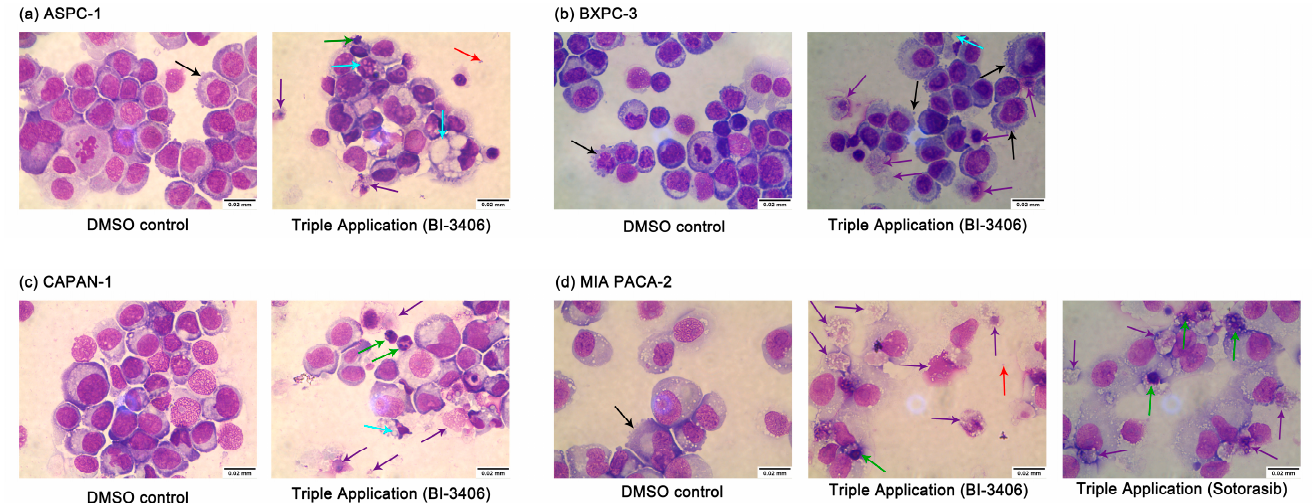
Figure 5. Morphology changes in ASPC-1 ( a ), BXPC-3 ( b ), CAPAN-1 ( c ), and MIA PACA-2 ( d ) after after DMSO or triple inhibitor combination exposure. Magnification: 100 × . ↑ membrane bub- DMSO or triple inhibitor combination exposure. Magnification: 100×. ↑ membrane bubbles, bles, membrane bound apoptotic body, ↑ vacuolization, ↑ apoptotic body, ↑ nuclear condensa- membrane condensation/fragmentation; ↑ rupture of the plasma membrane. tion/fragmentation; ↑ rupture of the plasma membrane.